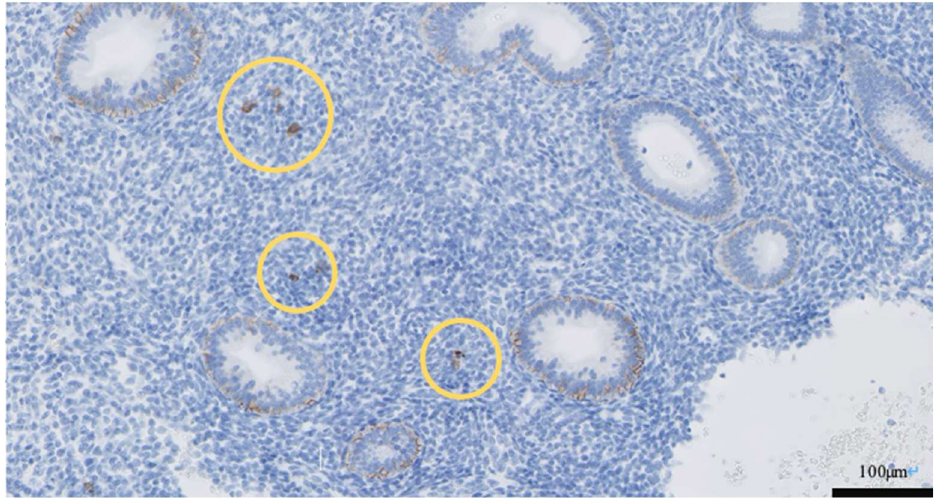
Figure 4. Histology of endometrium stained with CD138 immunohistochemistry at initial biopsy: CD138 positive cells are indicated by yellow rings. Scale bar =100 μm